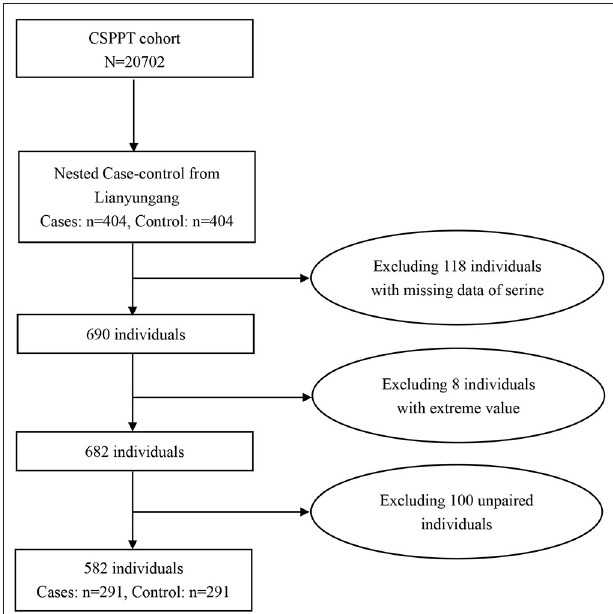
FIGURE 1 | Flow chart of the study